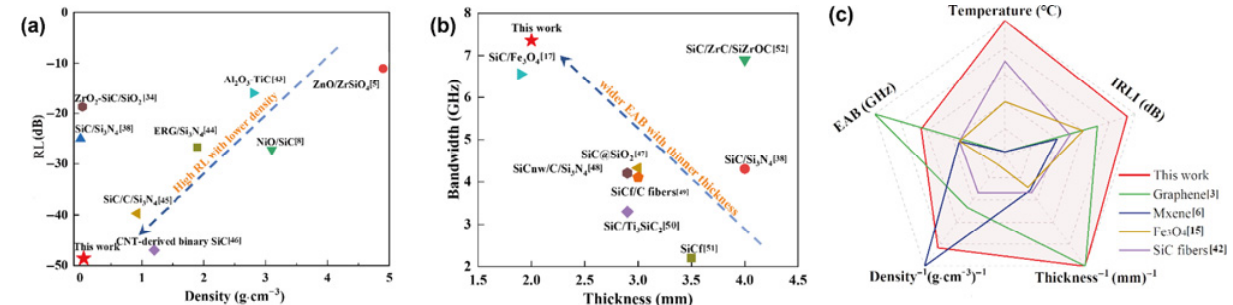
Fig. 9 (a) Comparison of microwave absorption properties of SiC/Si 3 N 4 composite aerogel and reported absorption materials: the functional relationship between RL min and density [43–46]. (b) Comparison of thicknesses and EABs of advanced EM wave absorption composites [47–52]. (c) Radar plot showing comparison among SiC/Si 3 N 4 composite aerogel, graphene, Mxene, Fe 3 O 4 , and SiC